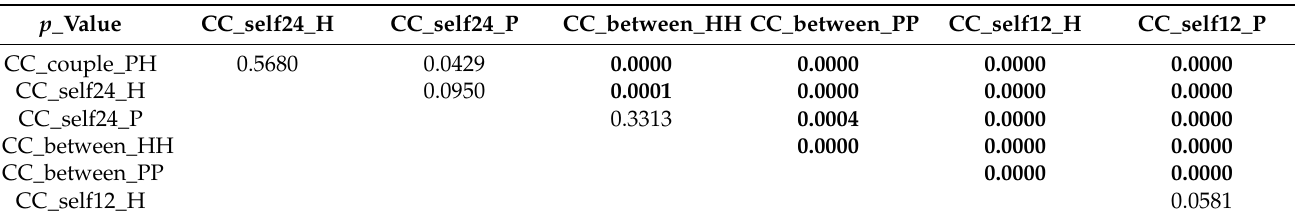
Figure 3. Correlation Coefficient (CC) of the identified analyses. Index CC quantifies the association between two MA profiles (+1 for perfect association, 0 for no association, − 1 for perfect opposite association). Each box plot reports median, quartiles, max and min values; possible outliers are marked with a “+”. Table 1. p -values of the post-hoc multiple comparisons of CC indices. The significance value is 0.05, corrected with Bonferroni to 0.0024 (N = 21). Significantly different comparisons in